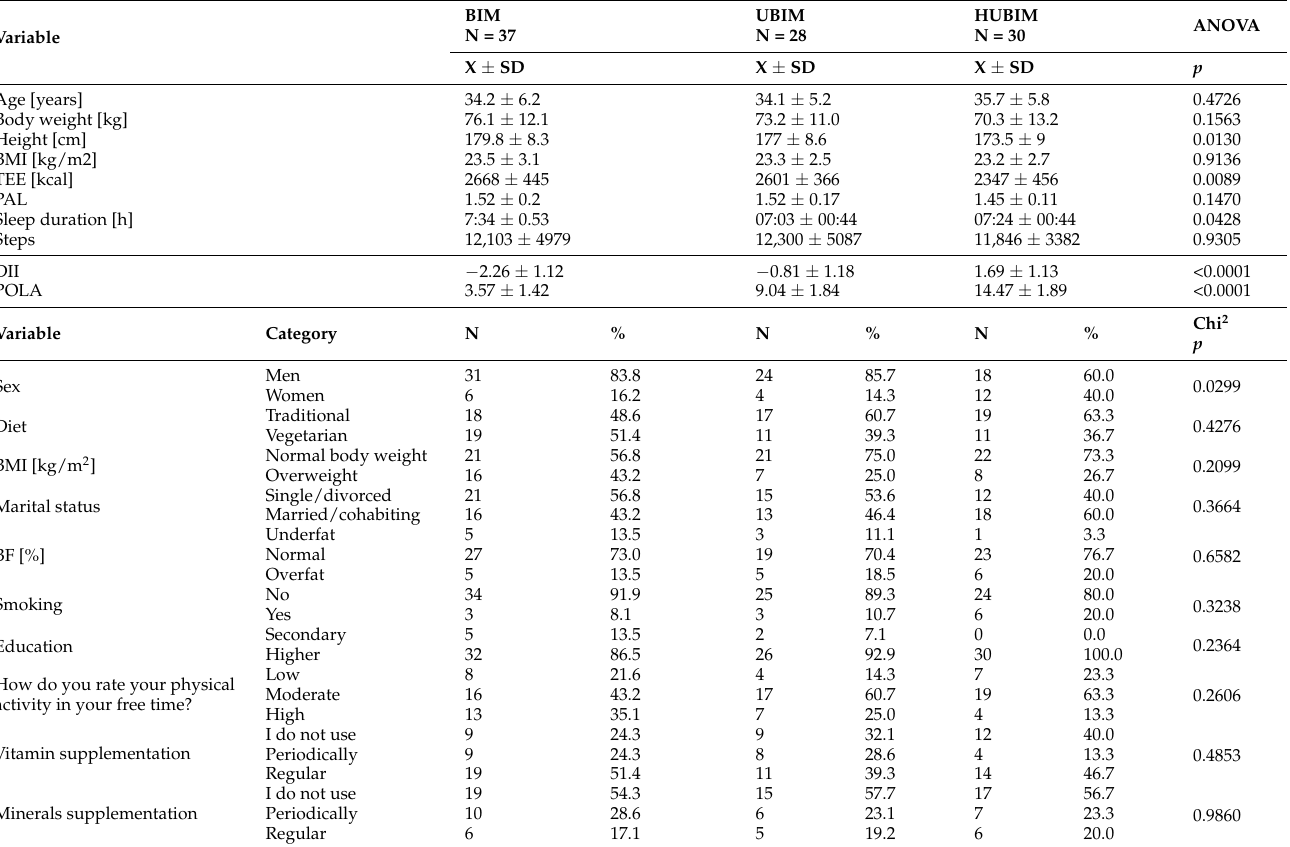
Table 2. Characteristics of subjects according to POLA index